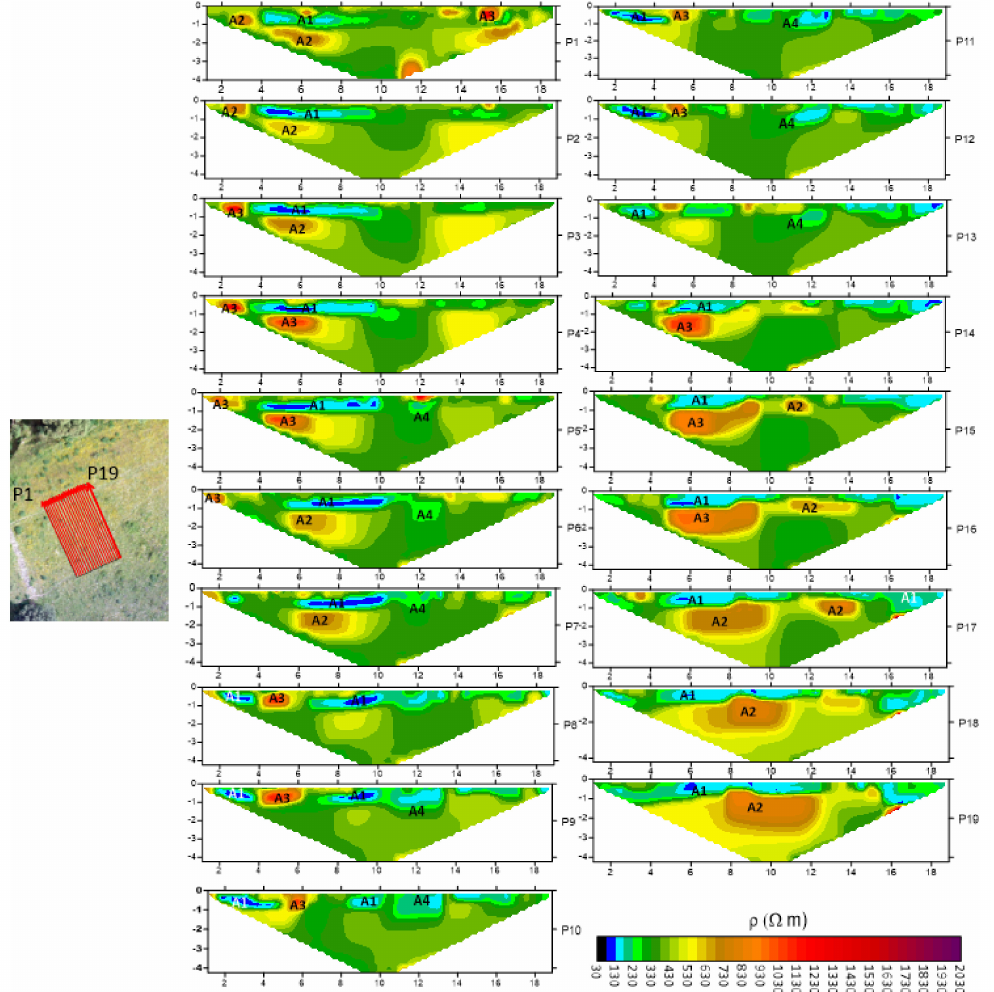
Figure 4. Left: locations of the profiles in the grid (the red arrows point towards the end). Right: resistivity distribution obtained via inversion for each profile. A1, A2, A3 and A4 are the main anomalies related to archaeological structures. In each plot, the horizontal axis represents the distances (in m) from the origin point, and the vertical axis represents the depth (in m) from the